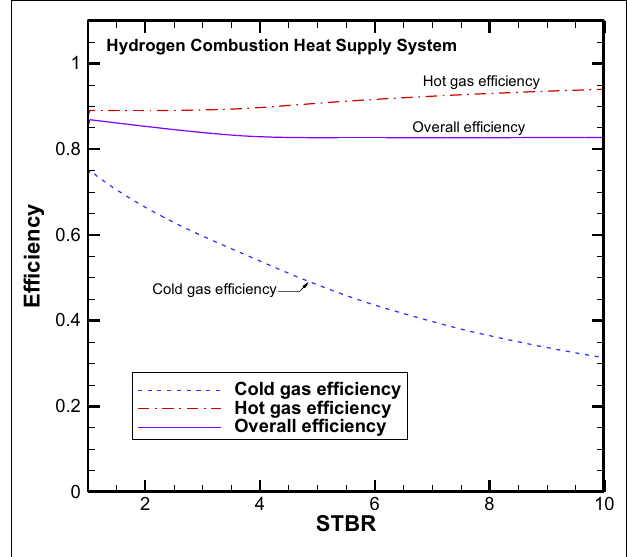
FIGURE 10 | Rate of external water required for concept system I as a function of STBR .